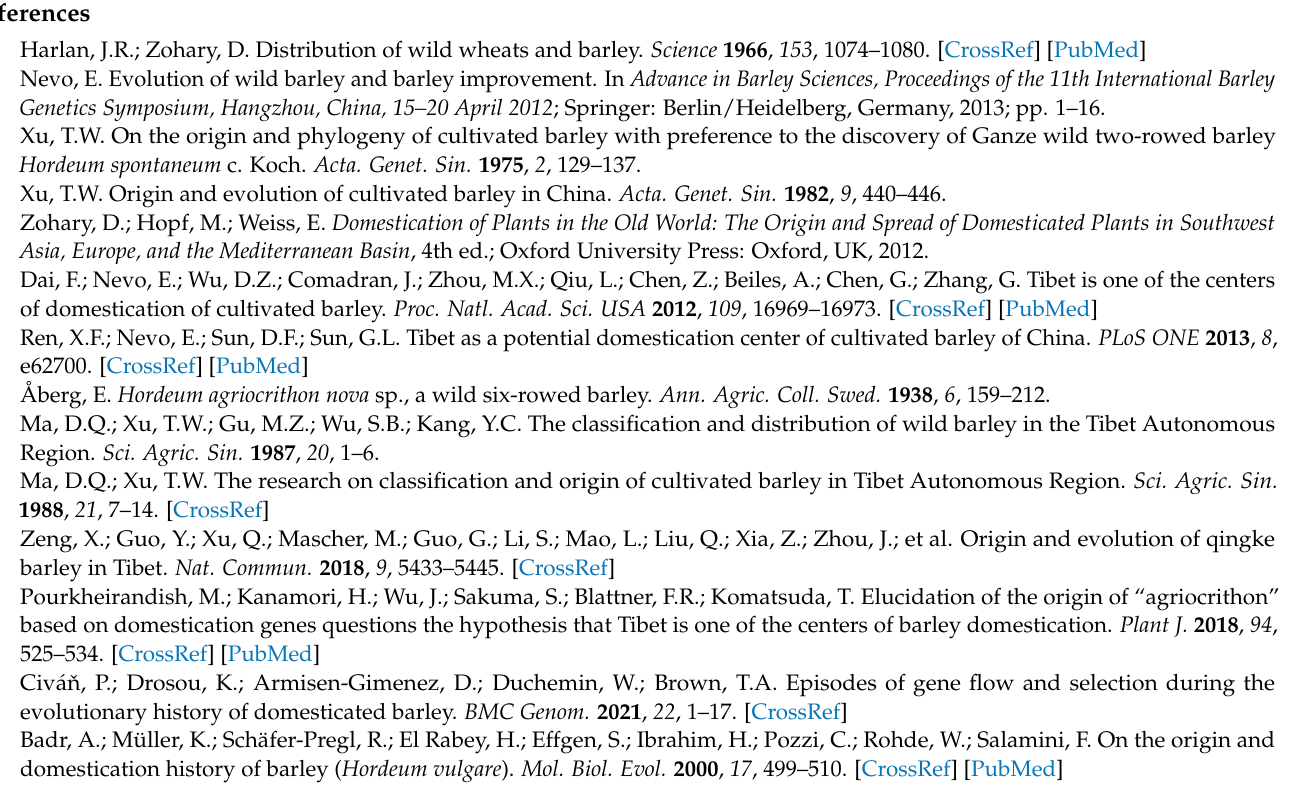
structure; Table S6: Divergent metabolites between Wb-NE and Wb-T; Table S7: Divergent